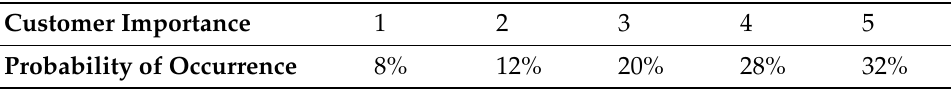
Table 4. Customer importance